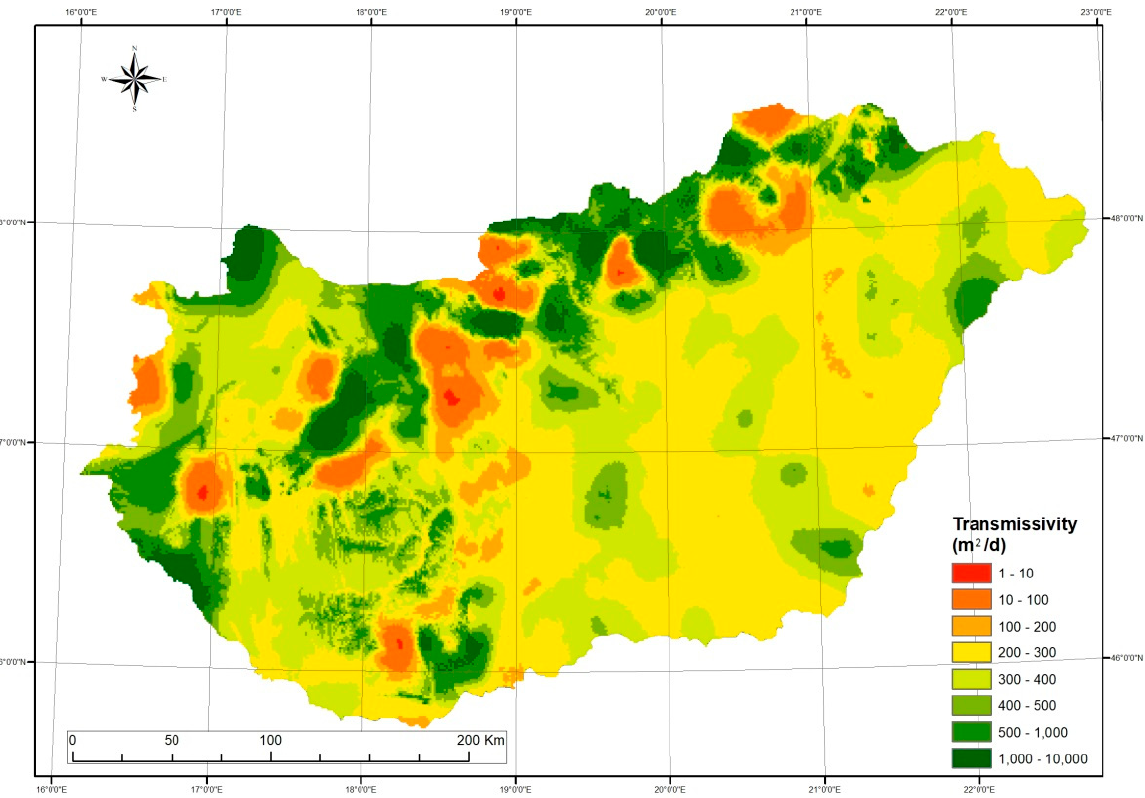
Figure 12. Calibrated transmissivity distribution.